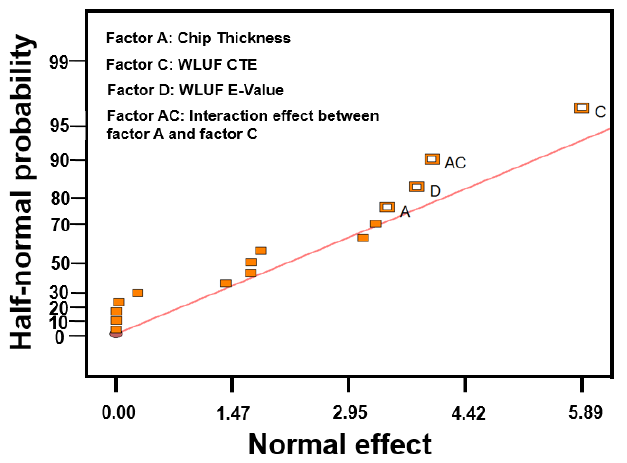
Figure 12. Half-normal probability plots for warpage effect.